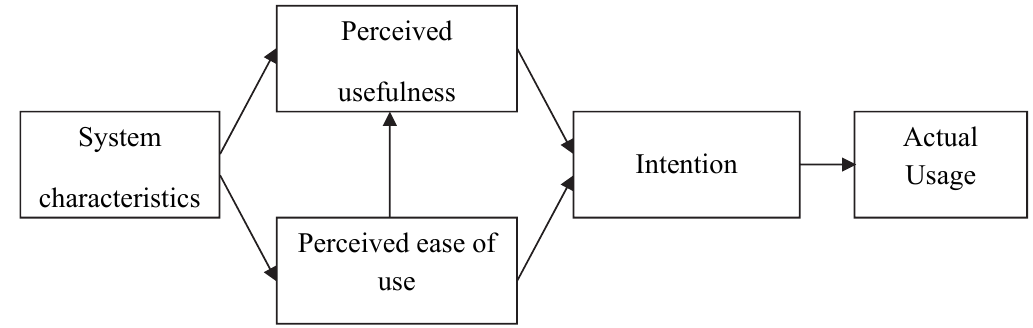
Fig. 1. Technology Acceptance Model